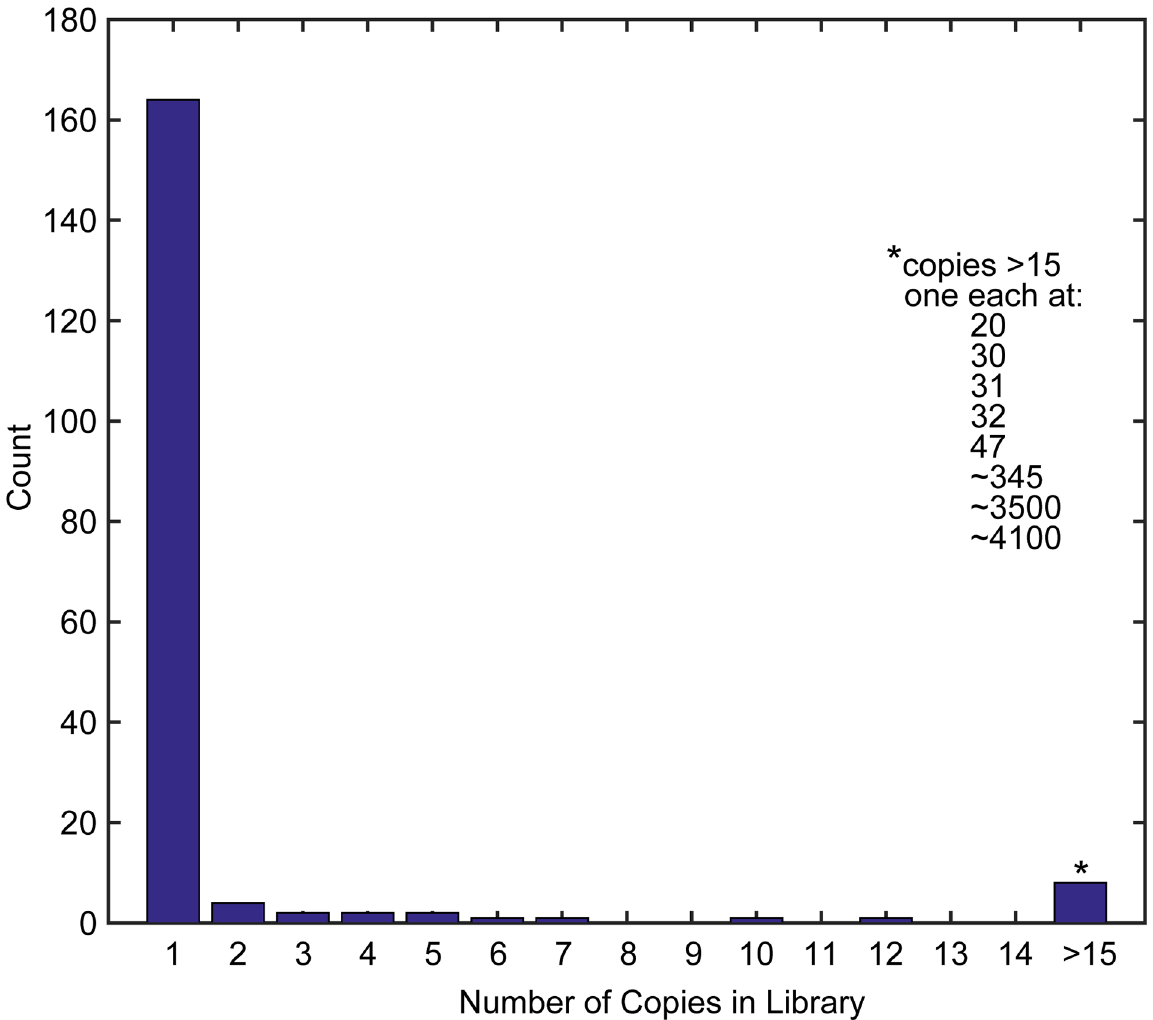
Fig 2. Histogram of sequence copy number in the library. Using 186 randomly-selected sequences from the library, a BLAST search was used to determine the copy number of each sequence within the library. For the 8 sequences present in greater than 15 copies the copy number of each example is listed in the